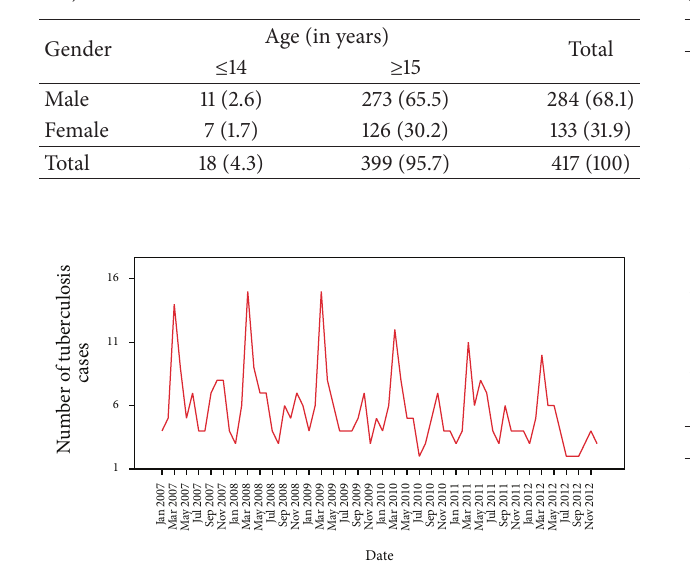
Table 1: Distribution of study subjects according to age and sex ( 𝑛 = 417 ).